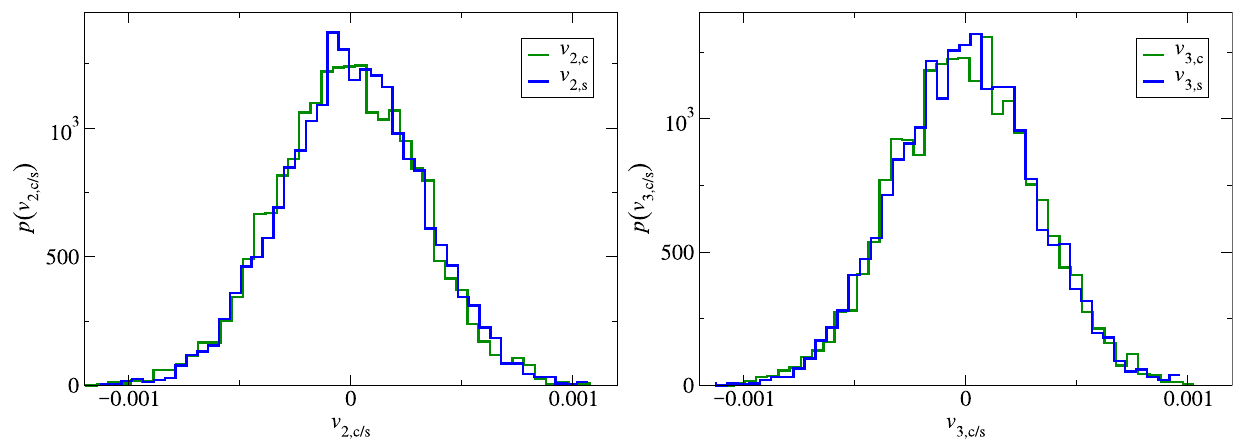
Fig. 7 Probability distribution of v 2 , c / s (left) and v 3 , c / s (right) in the initial state of the transport algorithm computed for 5000 events at b = 6 fm